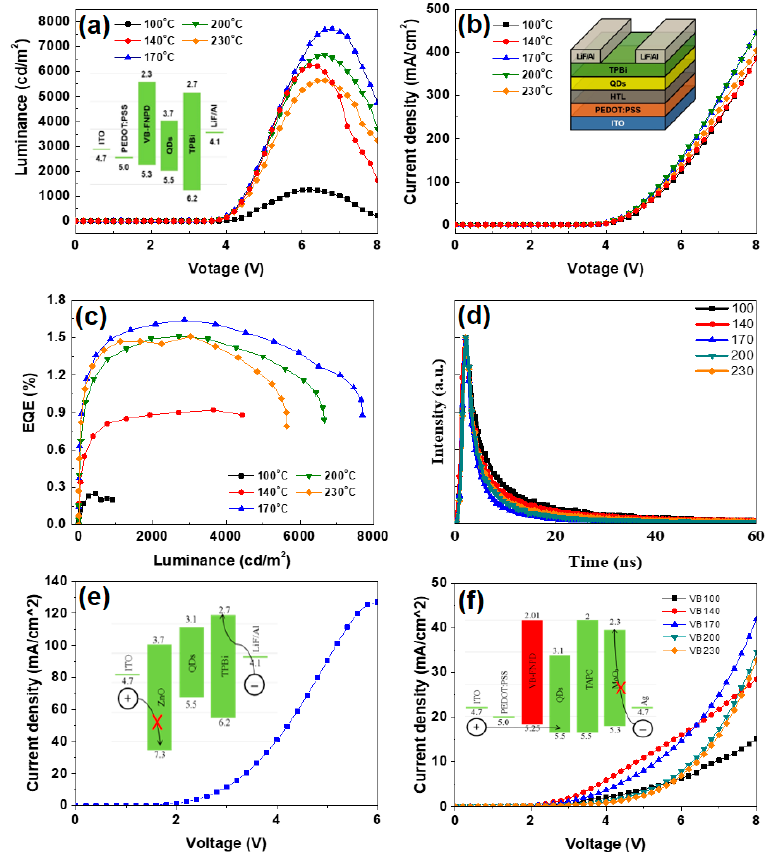
Figure 3. ( a ) Luminance-voltage (L-V), ( b ) current density-voltage (J-V), ( c ) external quantum e ffi ciency (EQE) for CsPbBr 3 QD-LED devices with VB-FNPD films crosslinking at di ff erent temperatures. The inset of ( a ) shows energy-band diagram of CsPbBr 3 QD-LED. ( d ) TRPL decay profiles of perovskite CsPbBr 3 QD layers on VB-FNPD films crosslinking at di ff erent temperatures. ( e , f ) show electron ‐ only and hole ‐ only devices for QD ‐ LED devices. The insets of ( a , e , f ) show energy ‐